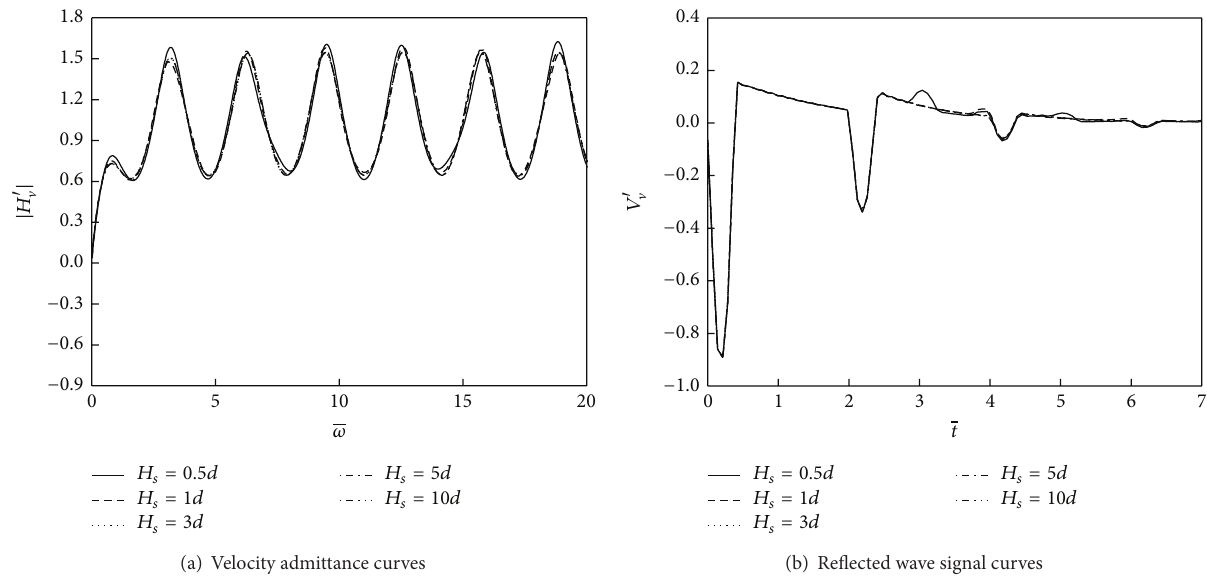
Figure 2: Influence of thickness of pile end soil on the dynamic response at pile head when 𝐻 𝑝 = 10 m.